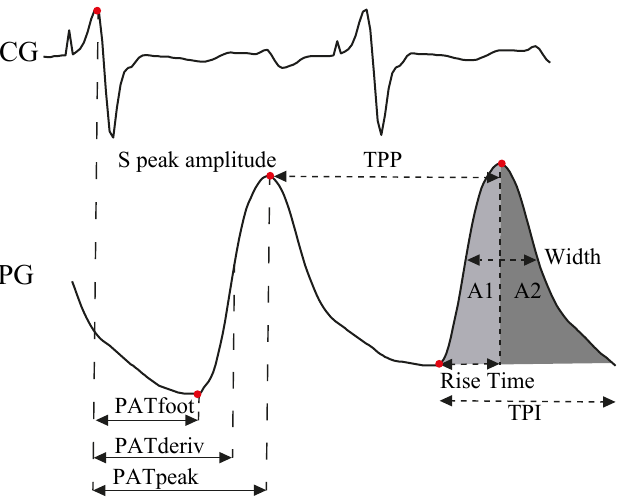
Figure 2. Representation of PAT foot , PAT derivate and PAT peak features obtained by the time interval between ECG R-peak and fiducial points of PPG signals as well as PPG morphological parameters: Systolic peak amplitude, TPP, rise time, areas under the pulse, width and